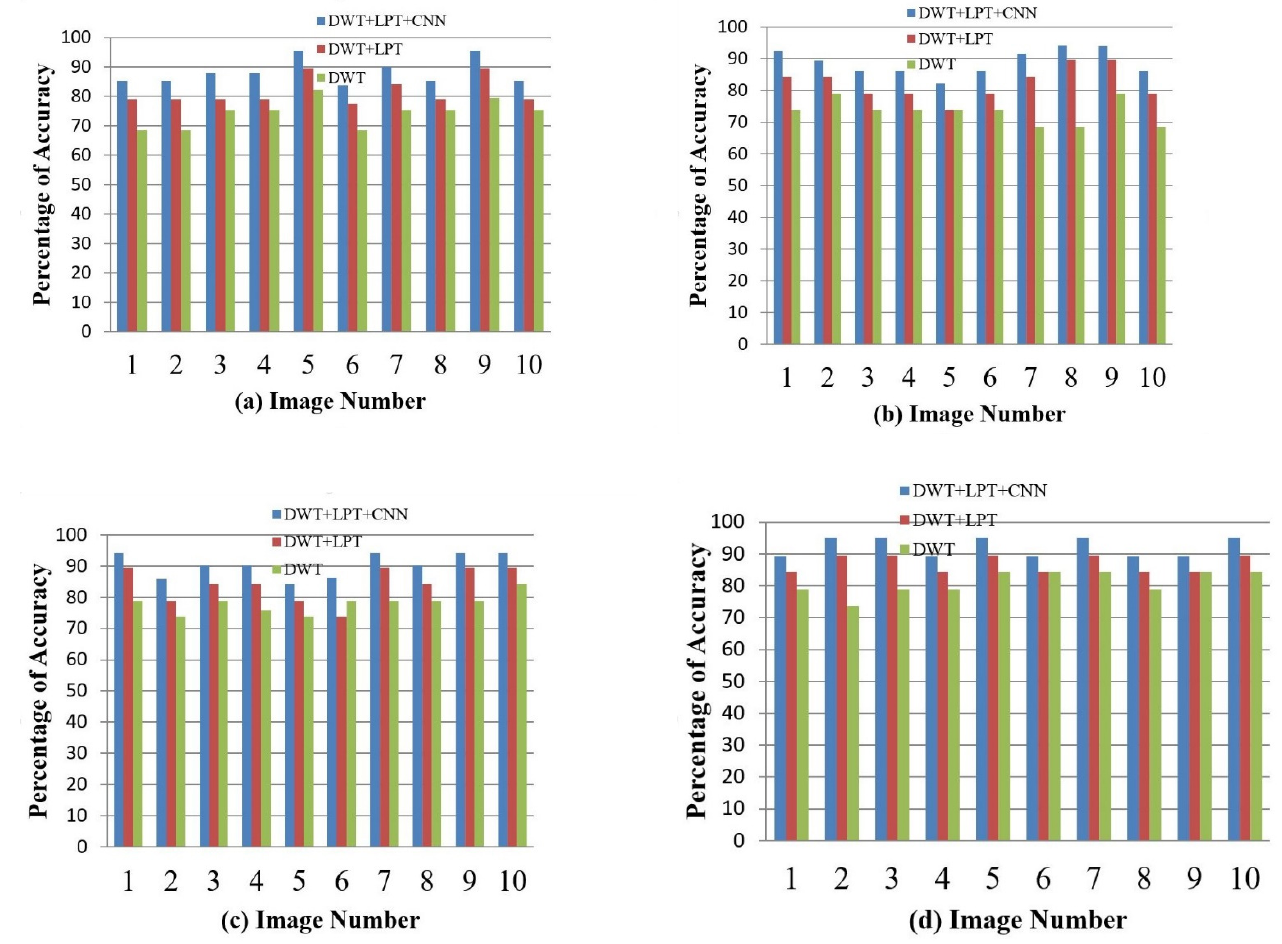
Figure 15. The accuracy percentages for the T-2 weighted images: ( a ) RBF; ( b ) Linear; ( c ) Polynomial; ( d ) Quadratic.